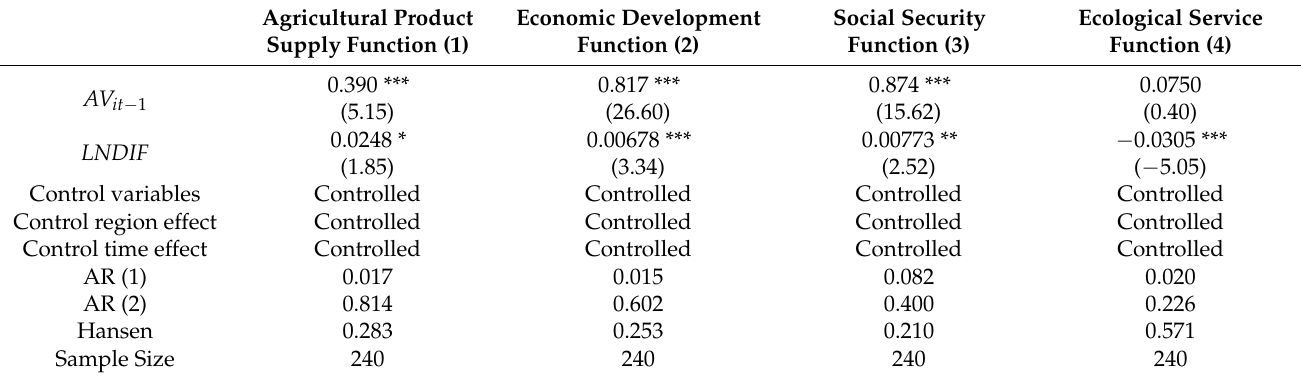
Table 6. Heterogeneity impact of digital financial inclusion on various agricultural segmentation